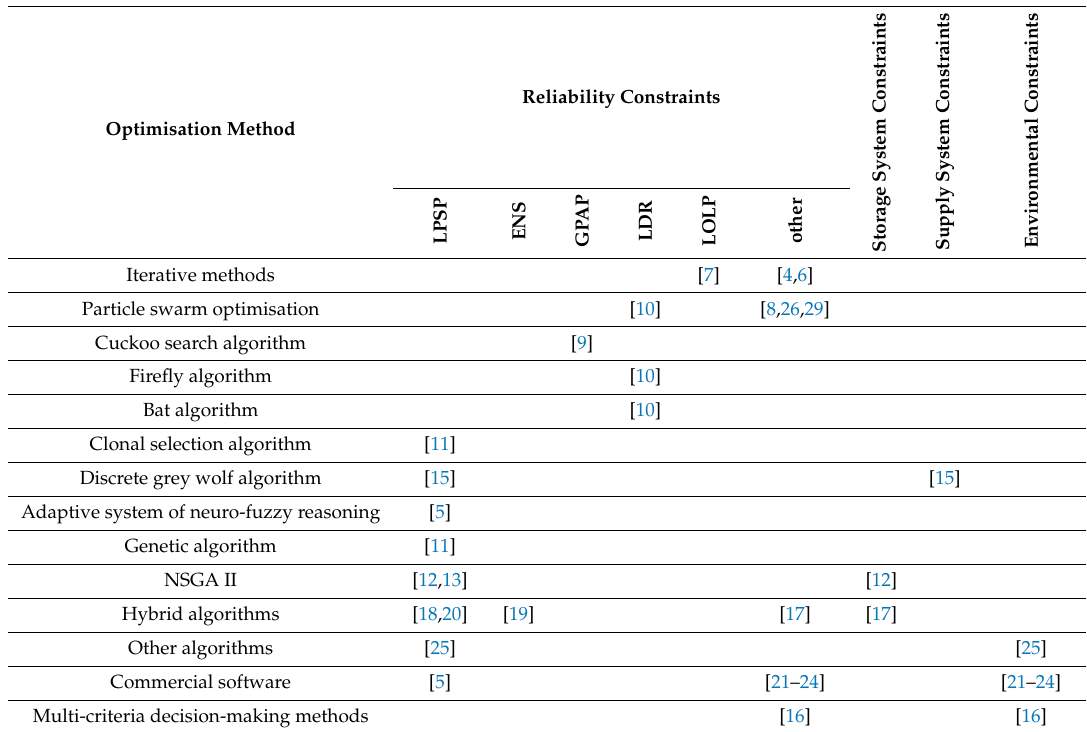
Table 2. Summary of publications in terms of optimization algorithms used (applied), as well as the constraints and